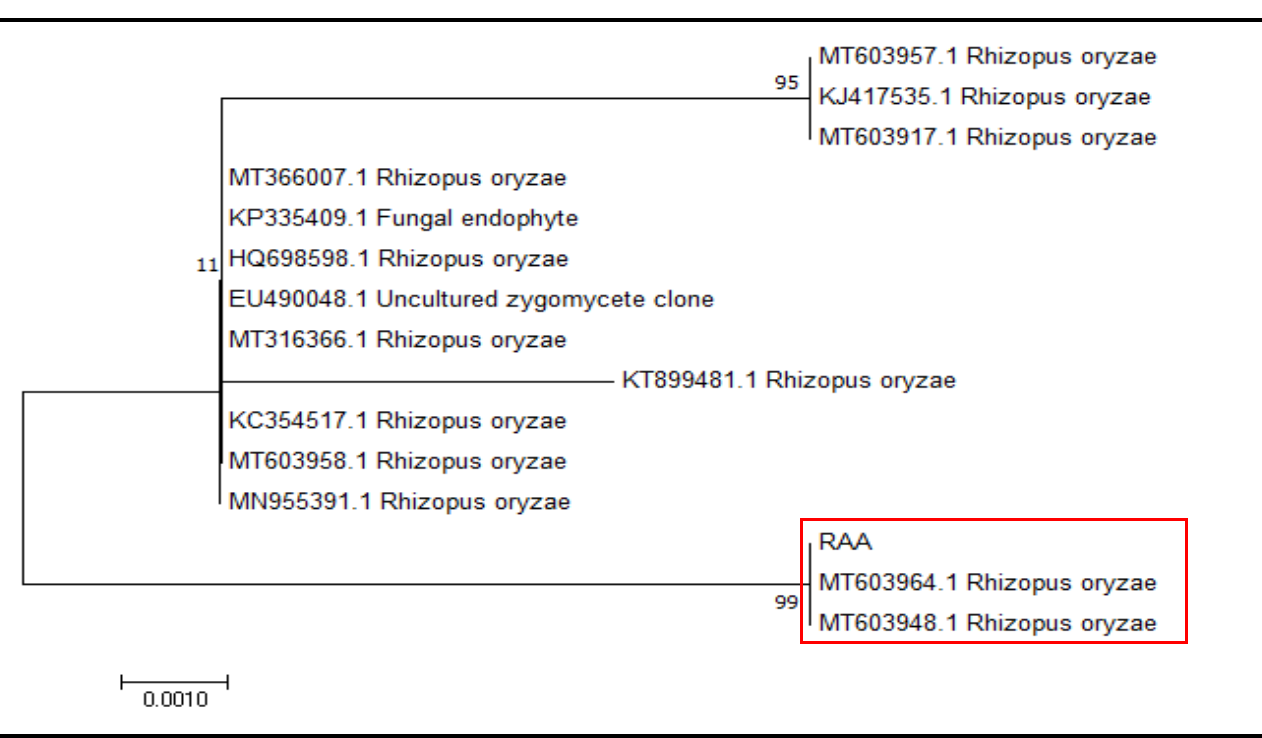
Figure 3. Phylogenetic study of the isolated R. oryzae sequence with 14 closely related ITS sequences after BLAST analysis. After 1000 replicates, the bootstrap values are presented at the branch points.